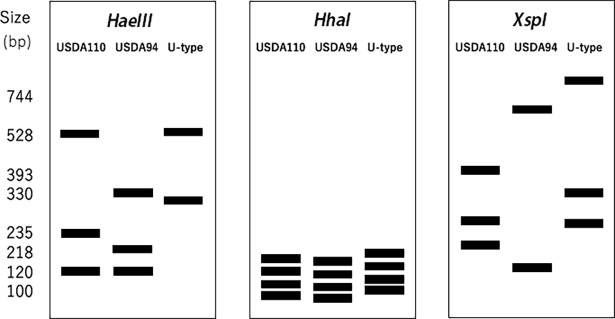
Schematic representation of amplicon patterns based on PCR-RFLP analysis of the l6S-23S rDNA internal transcribed spacer region of B. japonicum USDA110, B. elkanii USDA94, and Bradyrhizobium sp. (unidentified species).